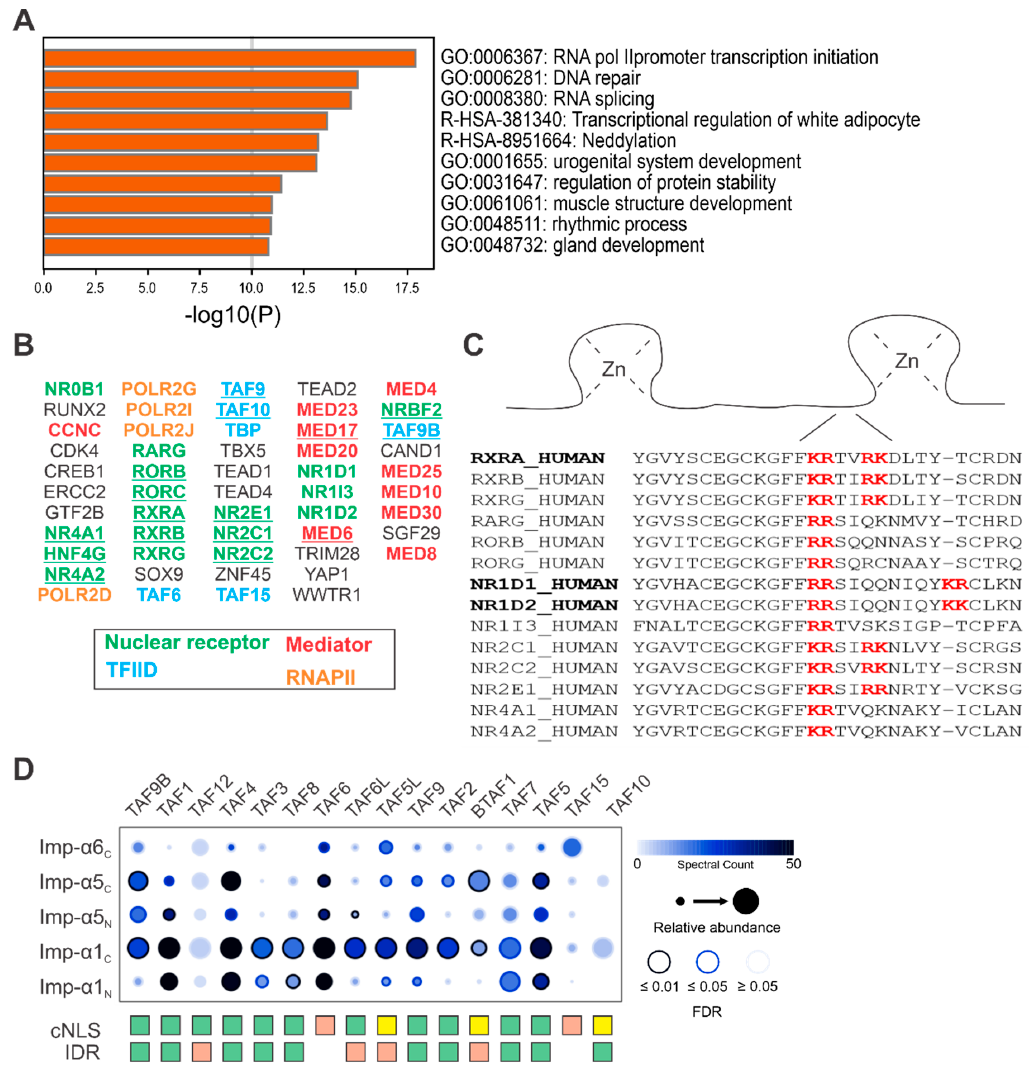
Figure 3. Identification of putative piggybacking proteins in non-cNLS nuclear proteins. ( A ) Nuclear proteins from the HPA without a predicted cNLS were analyzed using Metascape to identify enriched cellular processes. ( B ) Many of the proteins within the RNA polymerase II (RNAPII) transcription initiation cluster belong to related protein groups, such as the nuclear receptors, and distinct multi-protein complexes like transcription factor II D (TFIID), RNAPII and Mediator. Underlined proteins have a predicted cNLS as determined by cNLS Mapper. RNAPII is known to use piggybacking as well as several subunits of TFIID. ( C ) Although not suspected to piggyback, multiple sequence alignment with Clustal Omega of the identified nuclear receptors shows conservation of a motif (red) that has been previously shown to mediate nuclear import (bolded black) [68]. ( D ) Visualization of TAF interactions with Imp- α 1 and 5 (N- and C-terminal BirA* fusions) and Imp- α 6 (C-terminal BirA* fusion) shows that many TAFs are strongly associated with Imp- α 1. Several have a cNLS Mapper score ≥ 7 (green) while others have weaker cNLS Mapper scores that are < 7 but still greater than 5 (yellow). Those in red have scores below 5. Importantly, many of these predicted cNLSs are found within disordered regions (green) as determined by PONDR (VSL2).